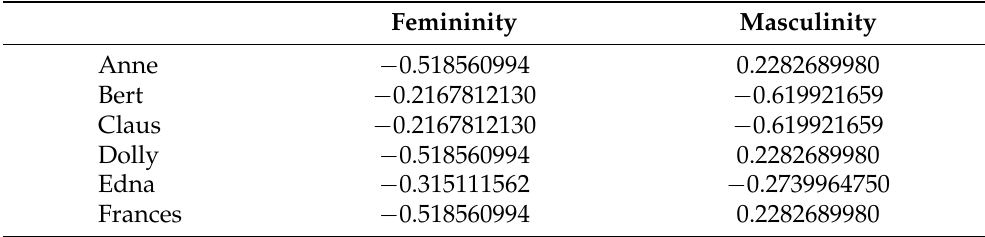
Table 5. Loading matrix A with the TuckerALS algorithm for behavioral level data.